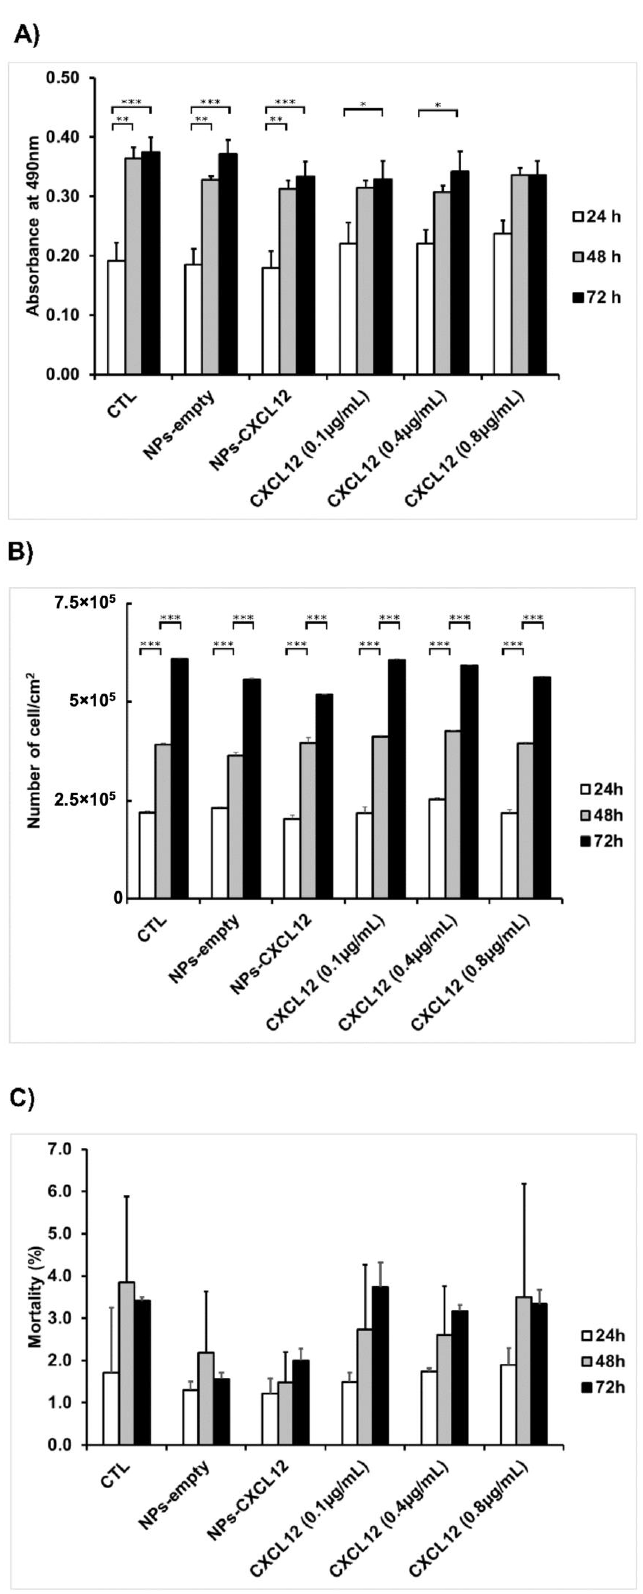
Figure 5. Cytotoxicity of NPs. ( A ) MTS assay results showing the absorbance measured at 490 nm (±SD), ( B ) Kinetic of F98 cell proliferation (±SD). ( C ) Percentage of cell mortality determined from live/dead cell viability assay. Results are representative of three independent experiments performed in duplicate. * p < 0.05, ** p < 0.01, *** p < 0.001.